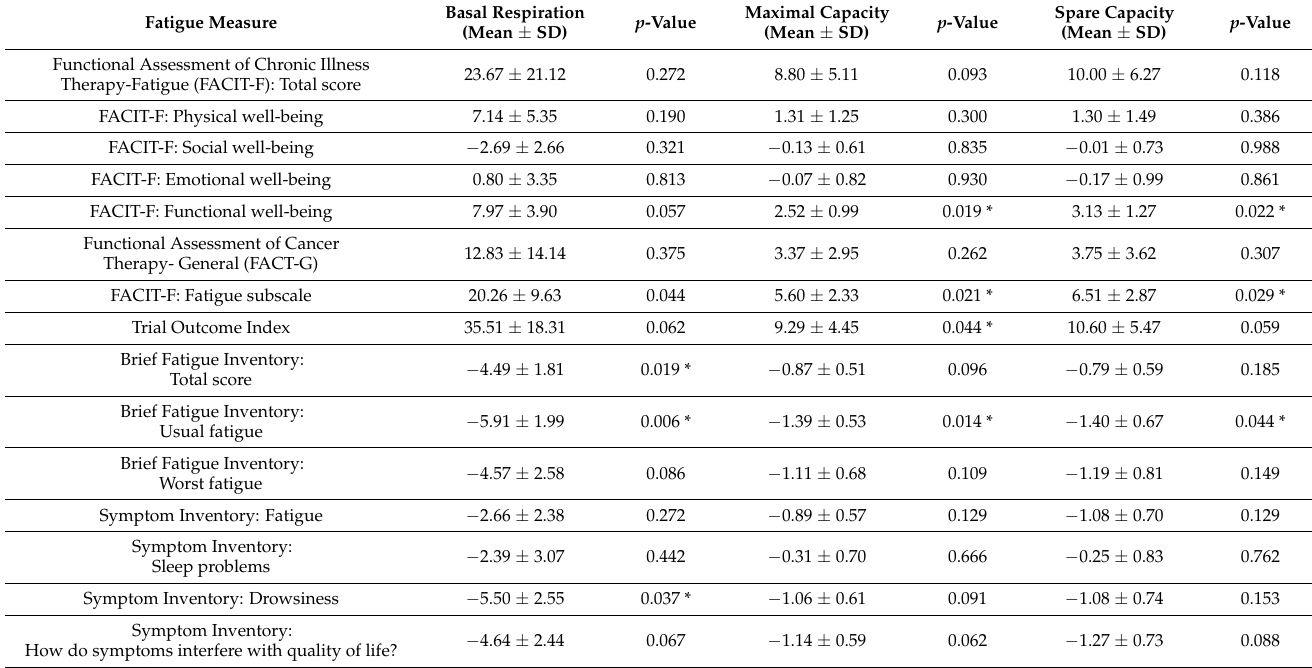
Table 3. Associations between mitochondrial measures and cancer-related fatigue incorporating data from baseline and four weeks. The mixed model had a first-order autoregressive repeated structure (AR[1]), fatigue as the dependent variable, participant as a random effect, and age and mitochondrial measure as fixed effects ( n = 30). For the Functional Assessment of Chronic Illness Therapy-Fatigue (FACIT-F), a higher score indicates less fatigue and a greater quality of life. For the Brief Fatigue Inventory and Symptom Inventory, a higher score indicates higher